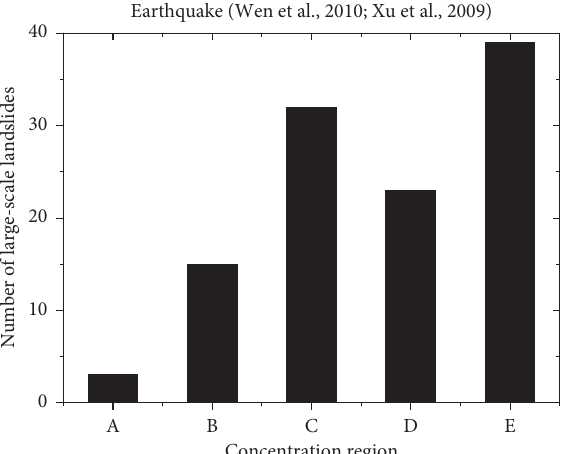
Figure 4: Number of large-scale landslides in different concentration regions